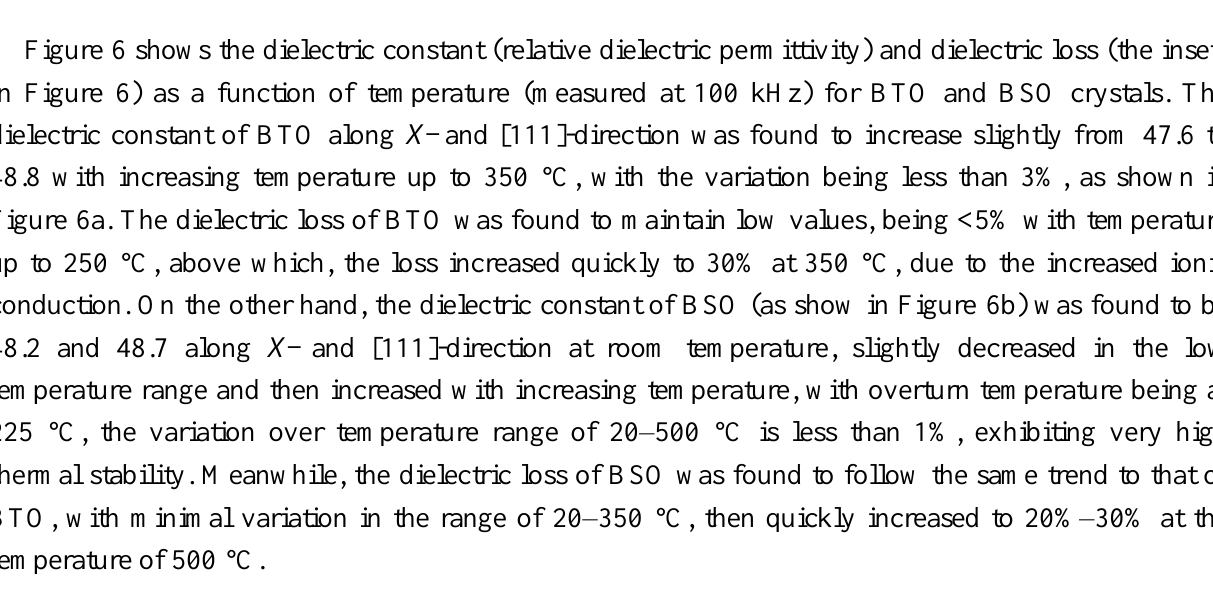
Figure 6. Dielectric behaviors as a function of temperature for BTO and BSO